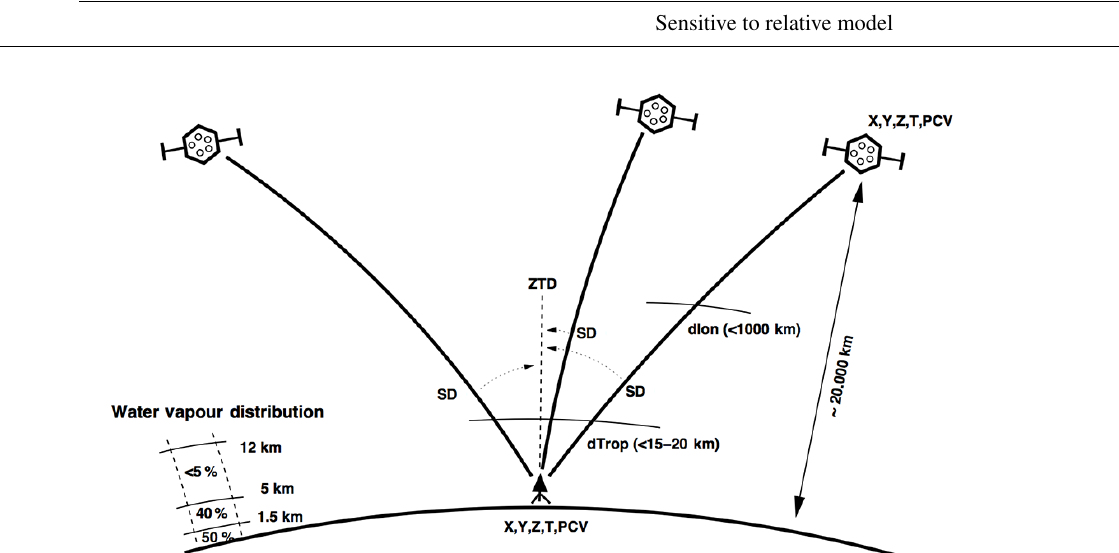
Figure 3. Schematic presentation of individual slant path delays (SPDs) from three GNSS satellites and their mapping to zenith total delay